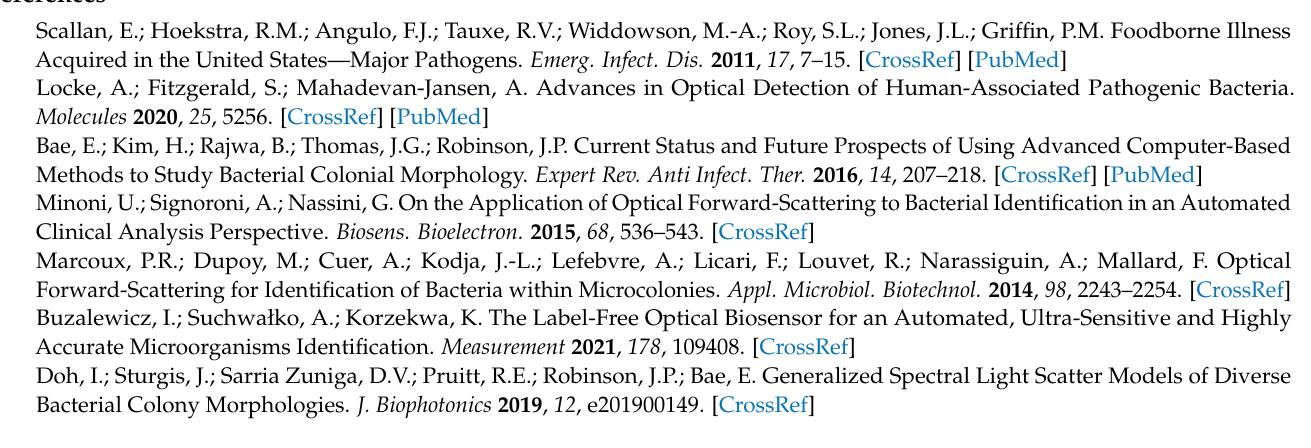
Figure S7: The schematic diagram and picture of HESPI with a mechanical solution to compensate for the beam spot movement at the imaging plane; Figure S8: A simple ray-tracing simulation of multiple lenses implemented in HESPI to minimize the beam spot movement at the imaging